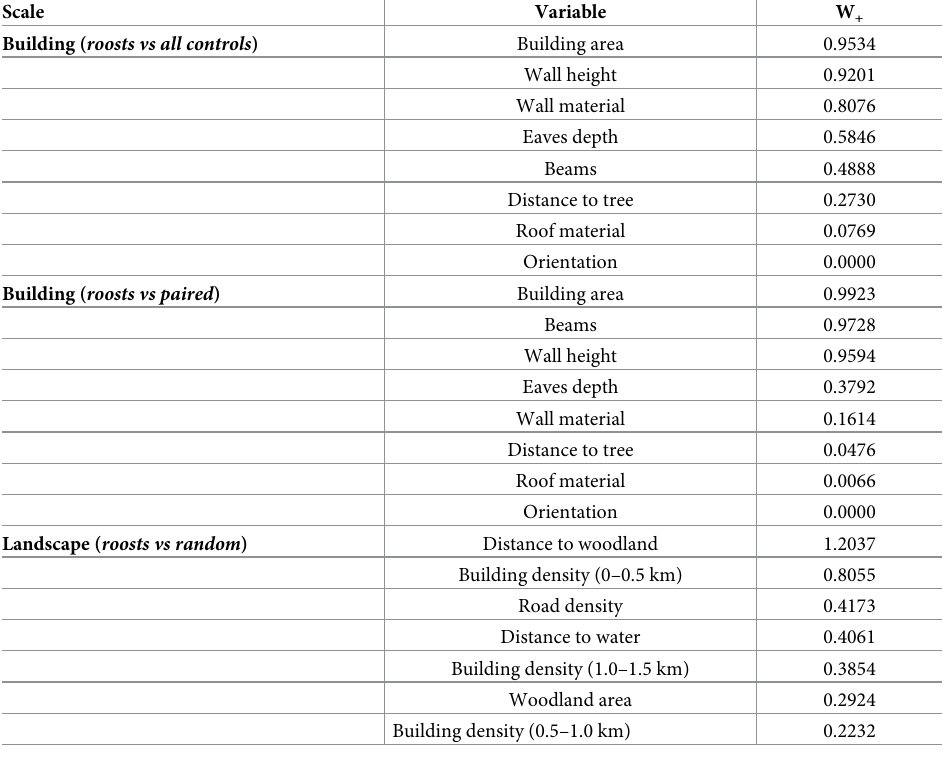
Table 2. The relative importance (W + ) of variables in predicting the presence of T . mauritianus on buildings throughout Lilongwe, Malawi. Scale Variable W + Building ( roosts vs all controls